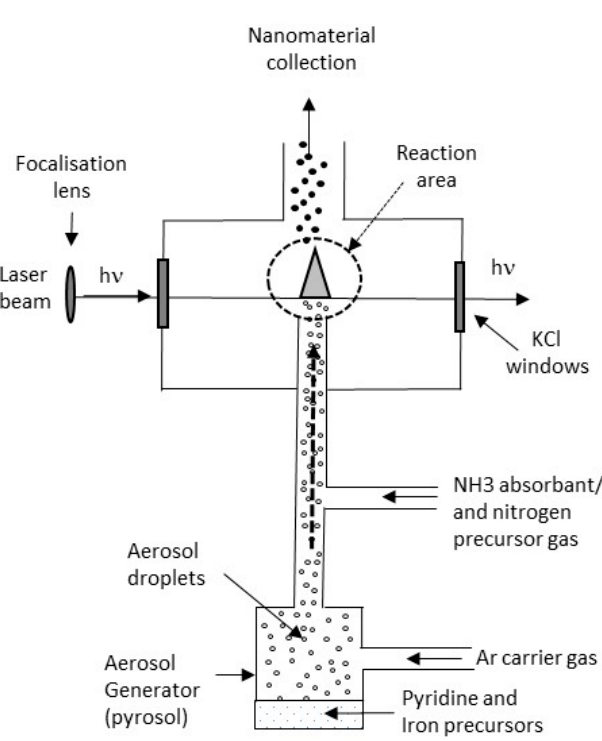
Figure 1. Scheme of the experimental set up used in this work.